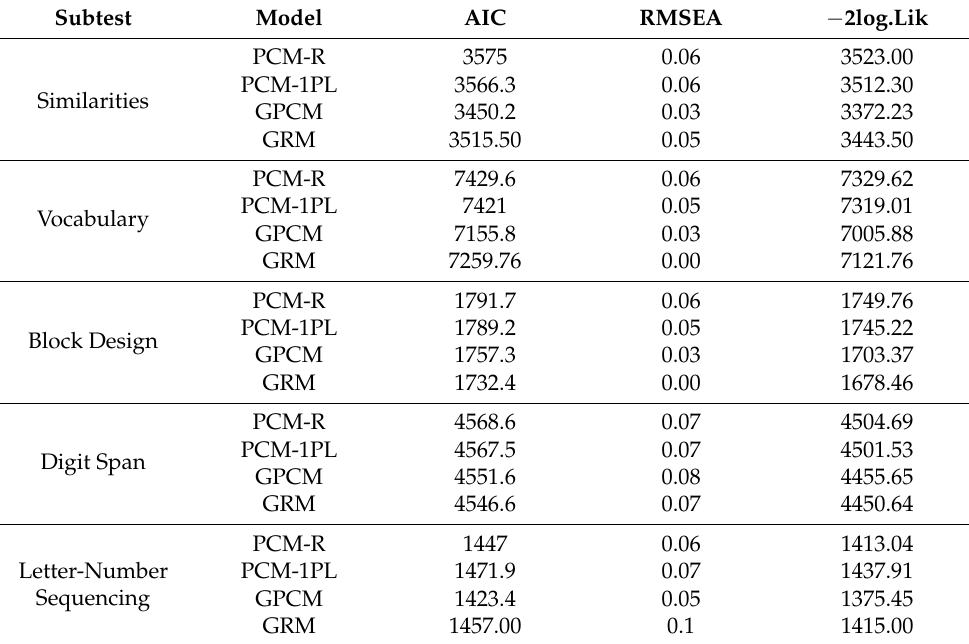
Table 4. AIC, M2, RMSEA, and LRT analysis for polytomous WAIS-IV